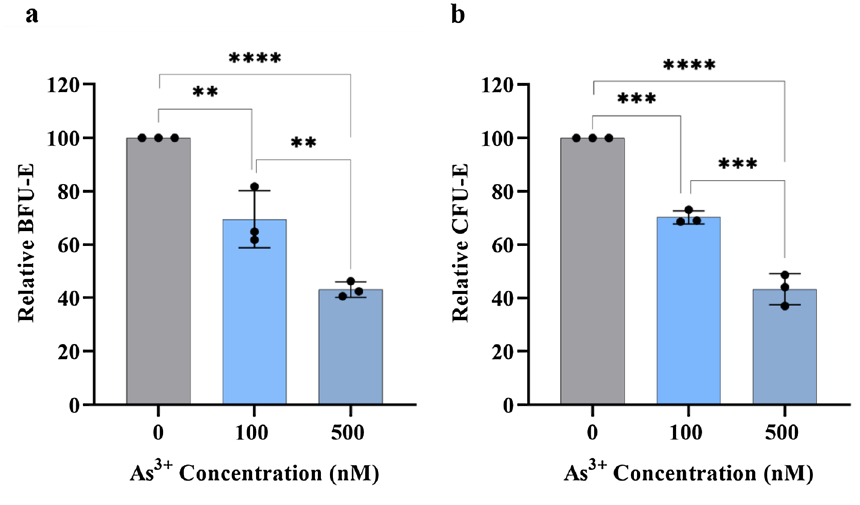
Figure 2. As 3+ exposure decreases BFU-E and CFU-E colony formation. Five-hundred human bone marrow CD34 + -HPCs were mixed with 1.1 ml of MethoCult™ medium containing 0, 100 nM, or 500 nM As 3+ . After 14–16 days of incubation, colonies were scored under an inverted light microscope. The relative number of BFU-E and CFU-E colonies for each group were calculated as described in the methods section. ( a ) Relative numbers of BFU-E colonies, ( b ) relative numbers of CFU-Es colonies. Data are expressed as mean ± SD, n = 3 replicates/group, **( p < 0.01), ***( p < 0.001), and ****( p < 0.0001) in one-way ANOVA, followed by Tukey’s post hoc test between the